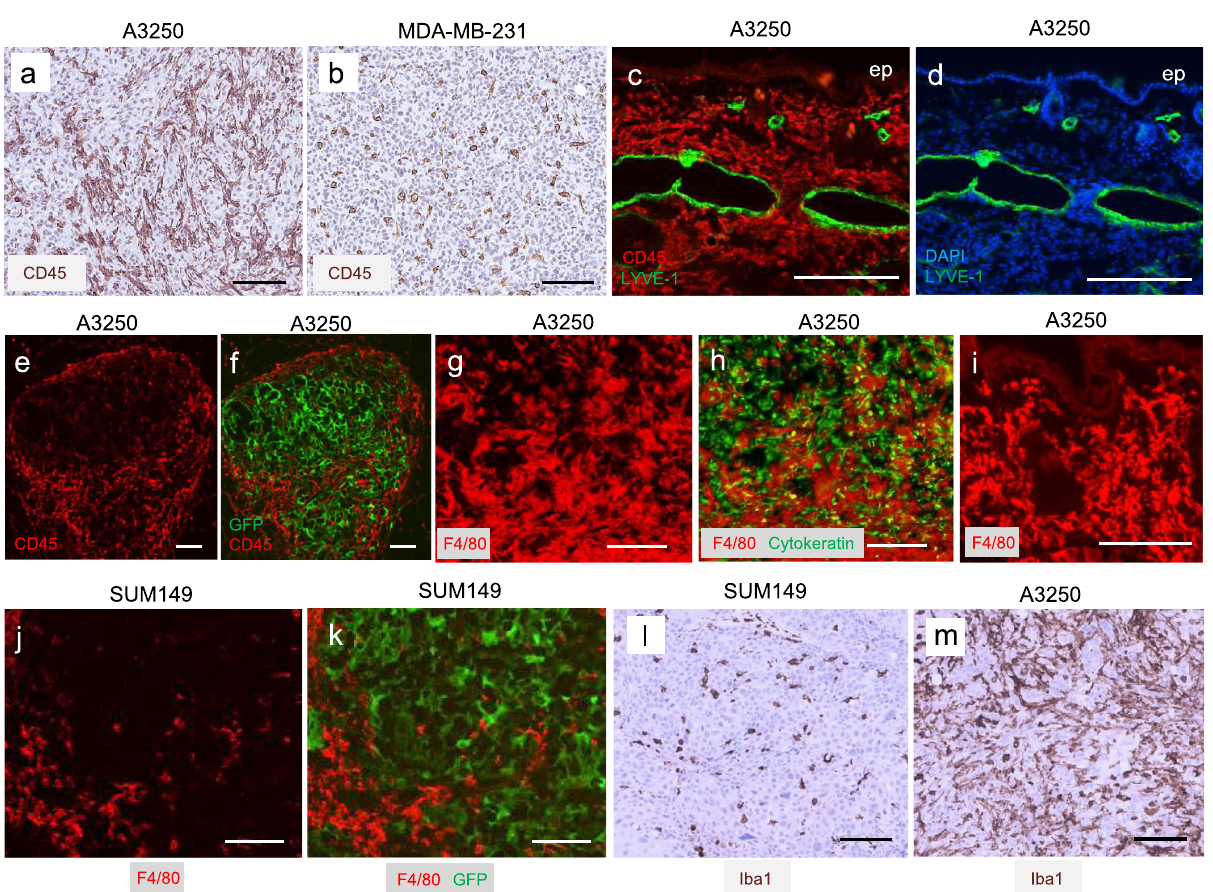
Fig. 4 In fl ammation associated with A3250 tumors by immunostaining analysis. a , b CD45 IHC staining of tumors at four-weeks as indicated. c , d Immuno fl uorescent staining of the skin adjacent to A3250 tumors for CD45 (red) and lymphatic marker LYVE-1 (green) at three-weeks (DAPI, blue). Note dense in fl ammatory in fi ltrate in the dermis and the absence of tumor cells within the lymphatics at this time point. e , f Immuno fl uorescent staining of A3250 tumor (GFP, green) for CD45 (red) at one-week post-injection. g , h Immuno fl uorescent staining of A3250 tumor for F4/80 macrophage marker (red) and cytokeratin (green) at four weeks as indicated. i Skin adjacent to A3250 tumor immunostained for F4/80. j , k Immunostainining of SUM149 tumor (GFP, green) for F4/80 (red) at four-weeks. l , m Iba1 IHC staining of tumors at four-weeks as indicated. Images are representative of three independent experiments. n = 3 biologically independent mice. Scale bars: 100 μ